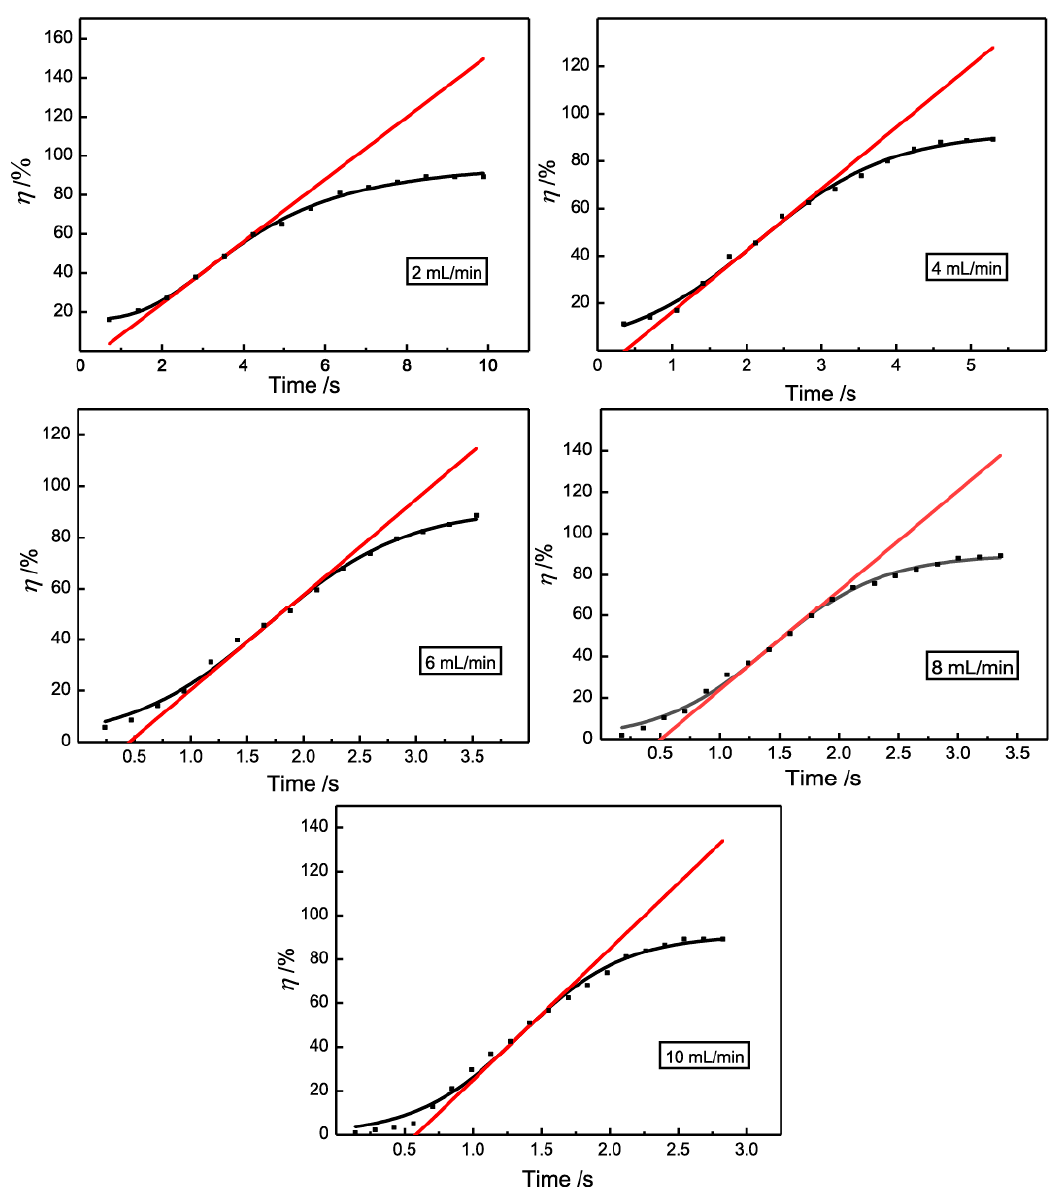
Figure 6. The S-logistic relationship between the de-emulsification efficiency and the resident